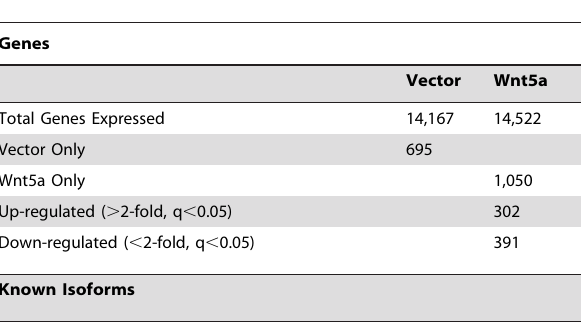
Table 2. Gene and Isoform Expression from CuffDiff.